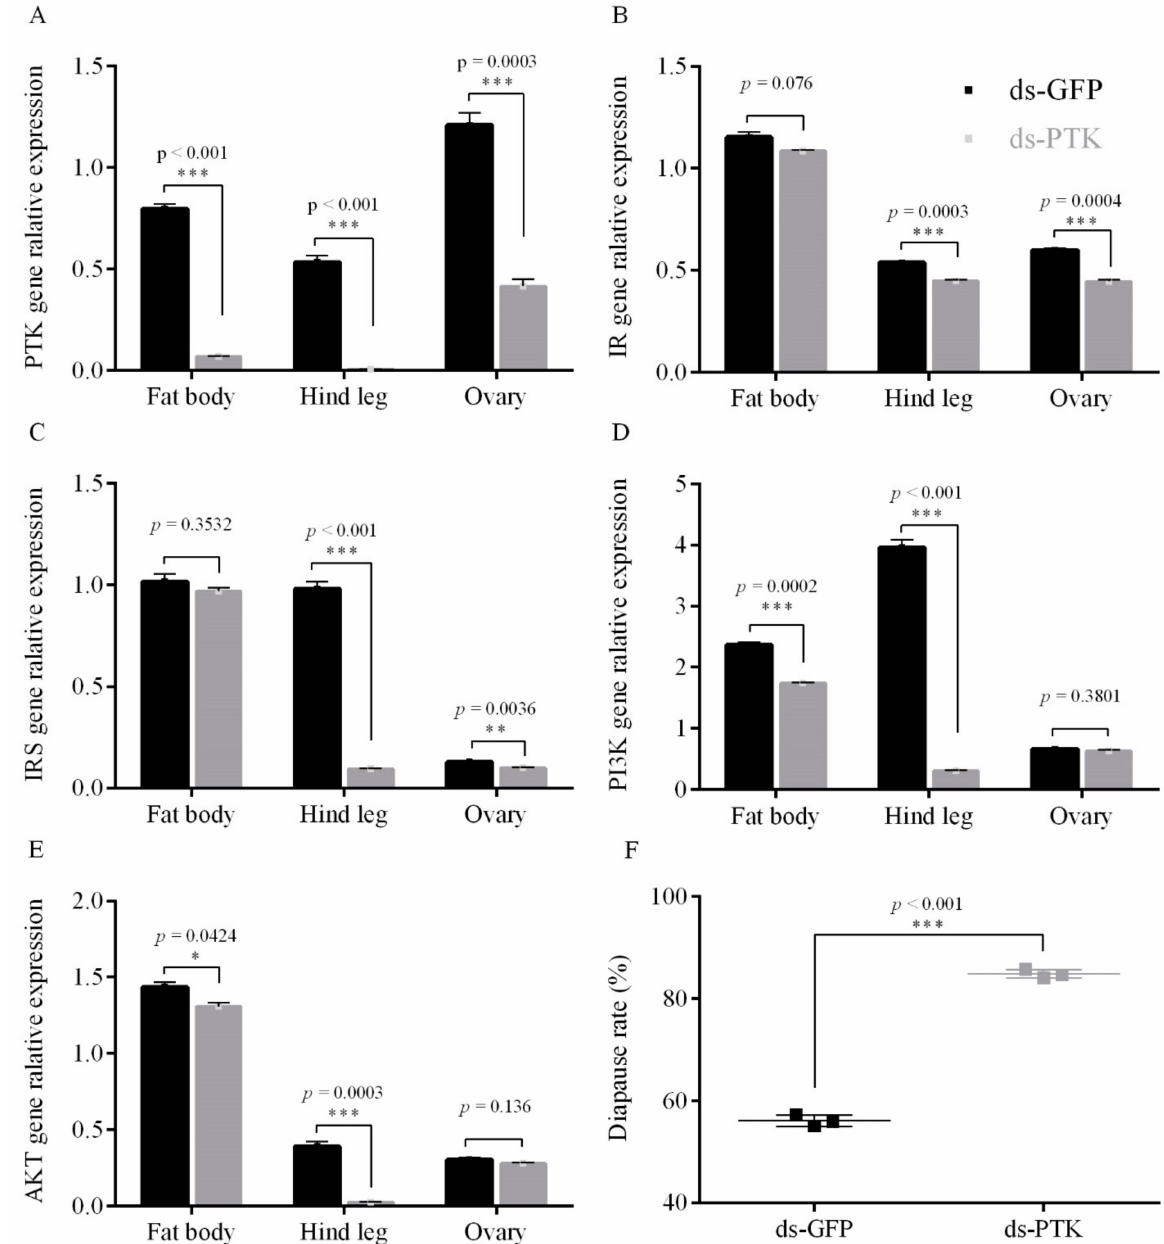
Figure 3. Gene relative expression and egg diapause incidence after injection of adults with RNAi PTK compared to GFP (control) under short photoperiod conditions (L10:D14) for ( A ) PTK gene, ( B ) IR gene, ( C ) IRS gene, ( D ) PI3K gene, ( E ) AKT gene and ( F ) egg diapause incidence. Data are the mean ± SEM from three independent replicates, the gray bar indicates RNAi treatments, while the black bar indicates GFP controls (* p < 0.05, ** p < 0.01, and *** p < 0.001 vs. GFP controls, Student’s t